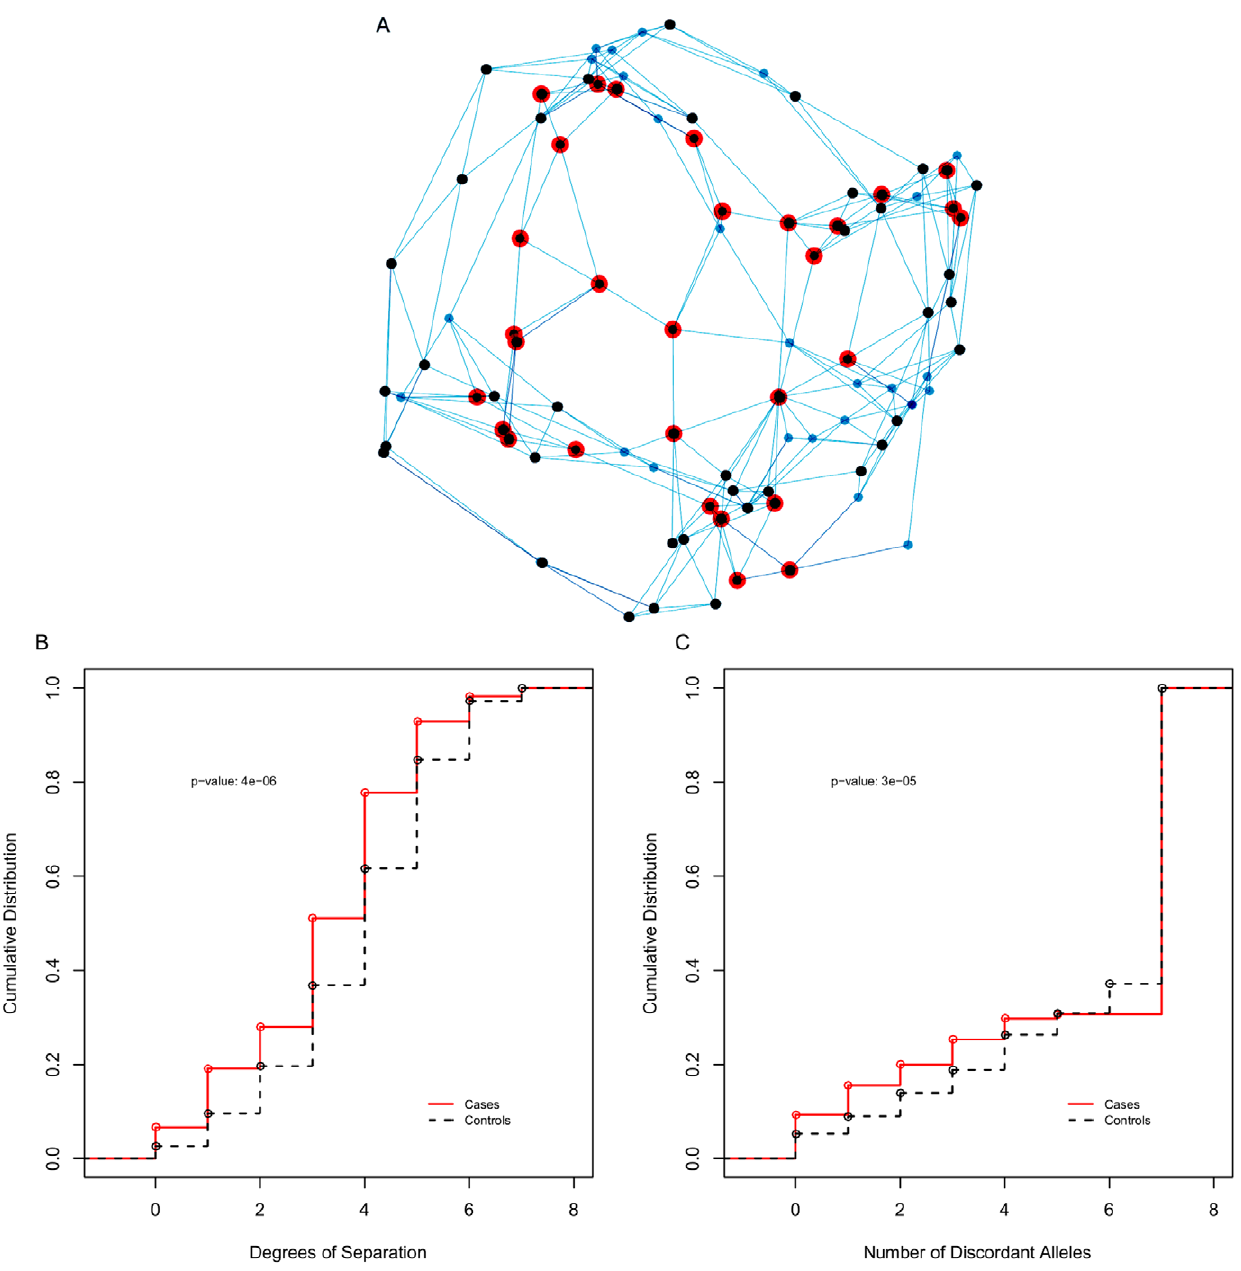
Figure 4. Simulated epidemic on the network. A) Spread of a new pathogen (large red nodes) on a small world network, with an endemic commensal pathogen (small black nodes). B) Cumulative distribution of the network distance for healthy controls in the network (dashed line) and only for individuals infected with the new pathogen (solid line). C) Cumulative distribution of the number of discordant alleles between pairs of isolates from healthy controls (dashed line) and cases (solid line). Both B) and C) show significant differences between cases and